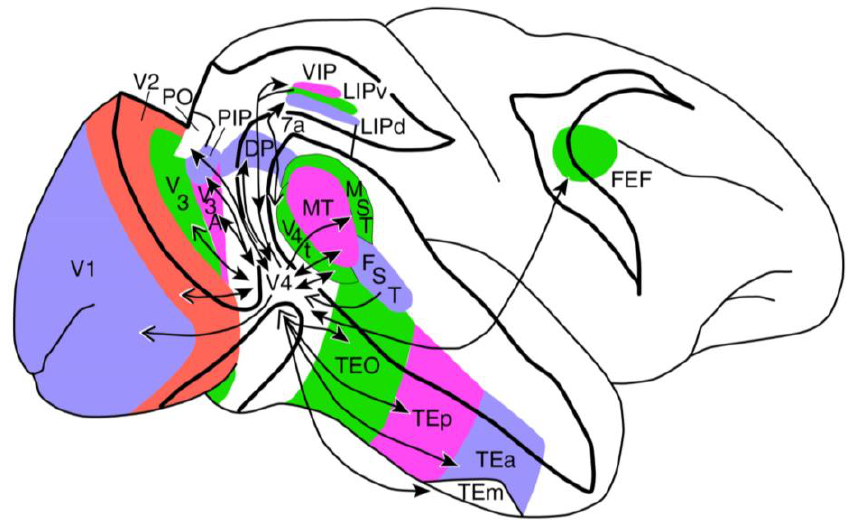
Figure 2. Location of the cortical visual areas in the primate. Open arrowheads indicate feedback projections, closed arrowheads indicate feedforward projections. Occipital areas: V1, V2, V3, V4—Primary (first), second, third, fourth visual cortices respectively, Temporal areas: TEO—Posterior inferior temporal cortex, TE—Anterior inferior temporal cortex, MT—Middle temporal area (fifth visual cortex), MST—Medial superior temporal area, FST—Fundus of the superior temporal area, Parietal areas: LIP—Lateral intraparietal area, VIP—Ventral intraparietal area, PIP—Posterior intraparietal area, PO—parieto-occipital sulcus, 7a—Visual area 7a in the parietal cortex (Brodmann‘s terminology), Frontal area: FEF—Frontal eye field. According to the figure of Ungerleider et al .